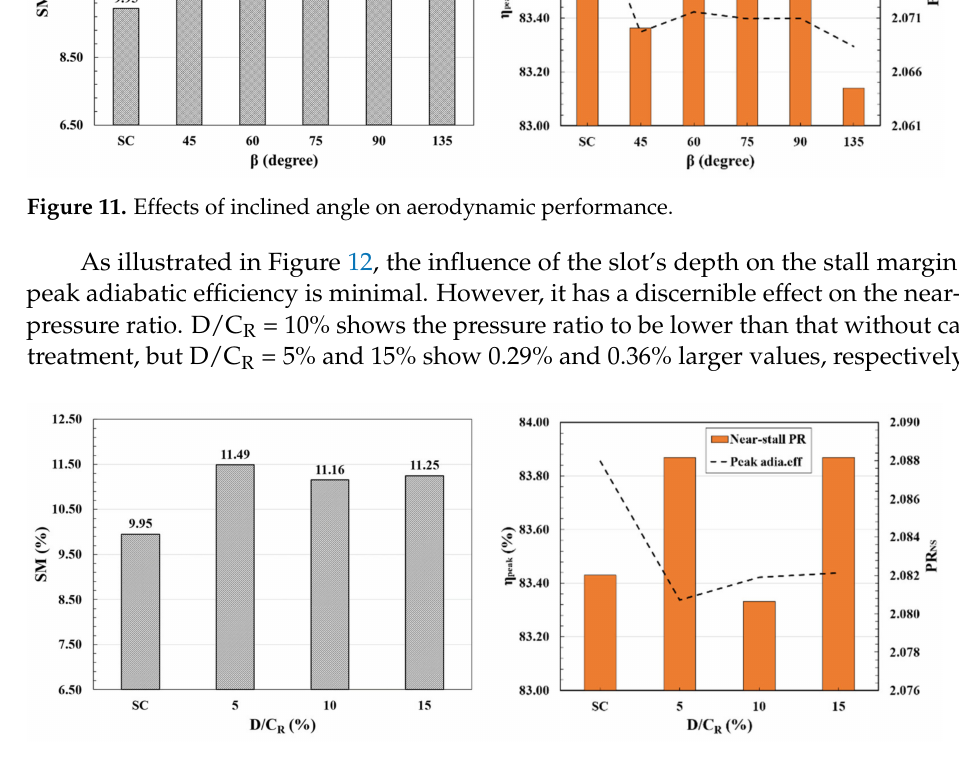
Figure 12. Effects of slot’s depth on aerodynamic performance.